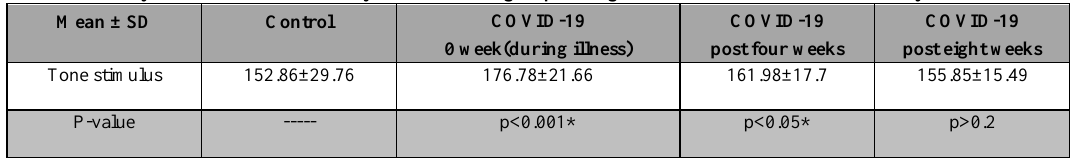
Table 3. Auditory reaction time in the study versus control group during and after 4 and 8 weeks of recovery from